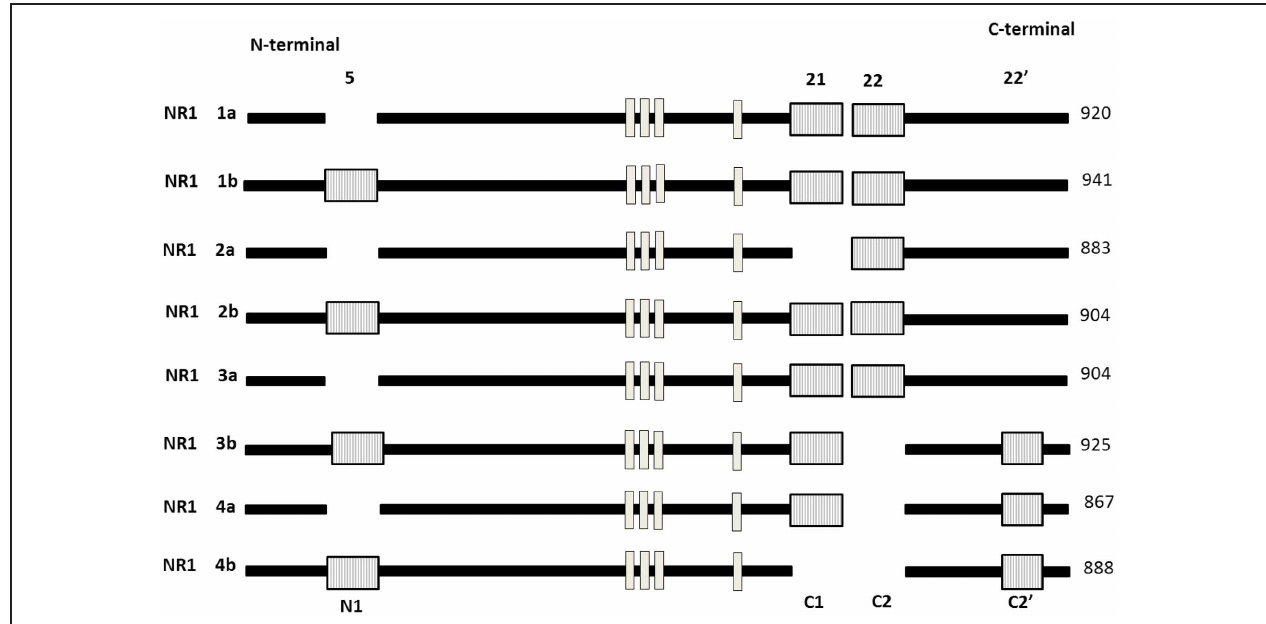
FIGURE 5 | Schematic representation of modular exon structure of the eight functional NR1 splice variants. Absence of (1–4A) or presence of (1–4B) of a 21 amino acid sequence close to the N-terminal region also illustrated. The length of the mature protein is given in amino acid (aa) in right side. There are three different